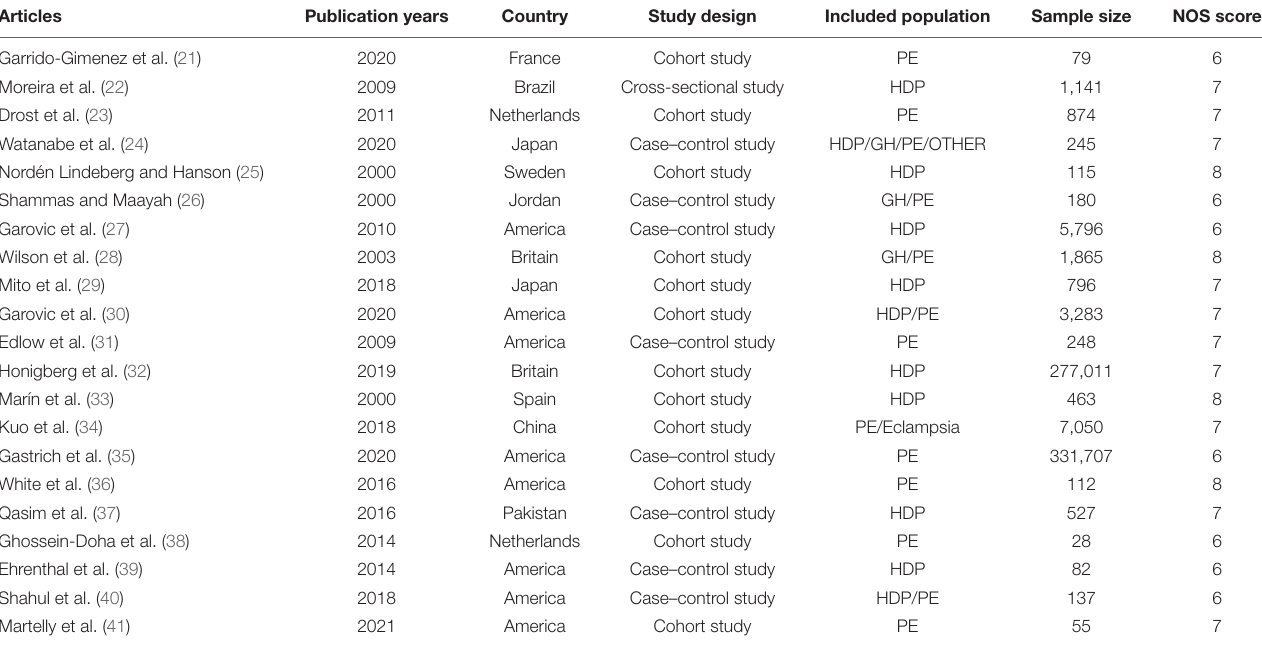
TABLE 2 | Summary characteristics of the 21 studies included in the systematic review of pregnancy